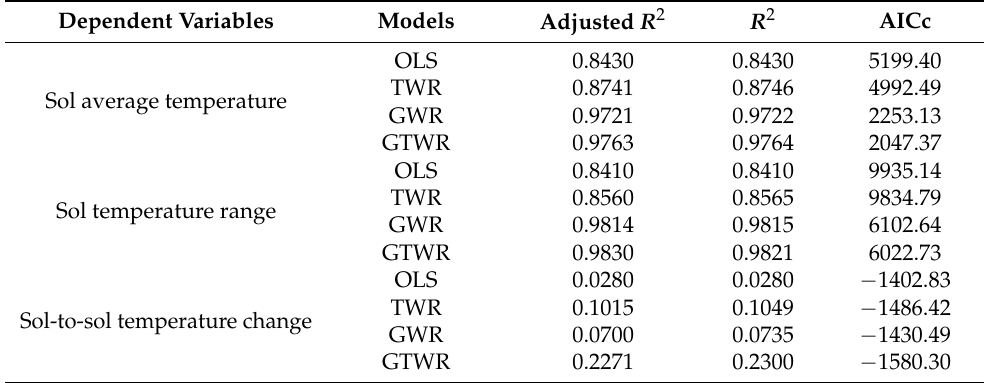
Table 2. Performance of the OLS, TWR, GWR, and GTWR